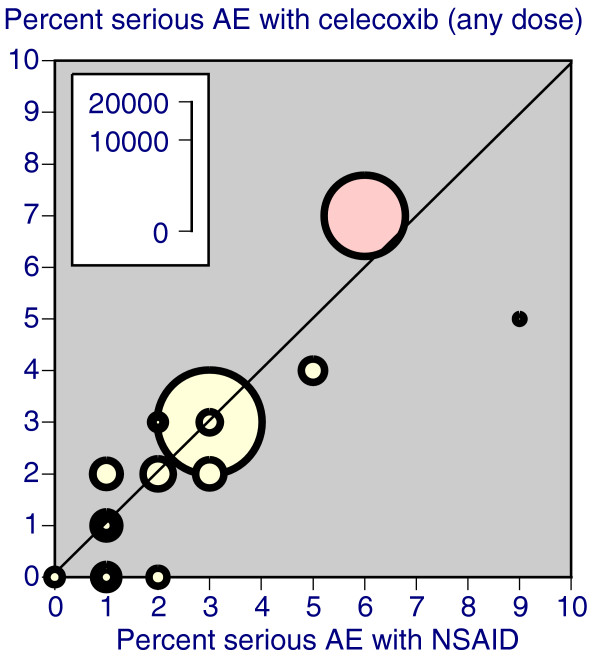
Scatter plot of trials comparing any dose of celecoxib with NSAID for serious adverse events. The red symbol represents the longest trial, at 52 weeks. AE, adverse events; NSAID, nonsteroidal anti-inflammatory drug.